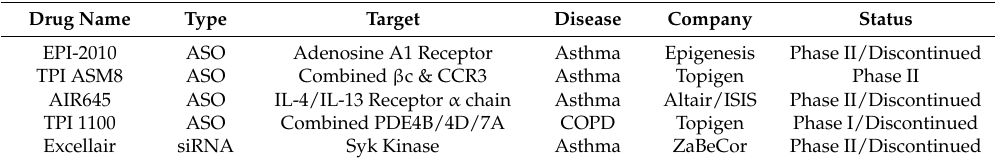
Table 1. Oligonucleotide drugs for asthma, COPD and pulmonary fibrosis entered into clinical